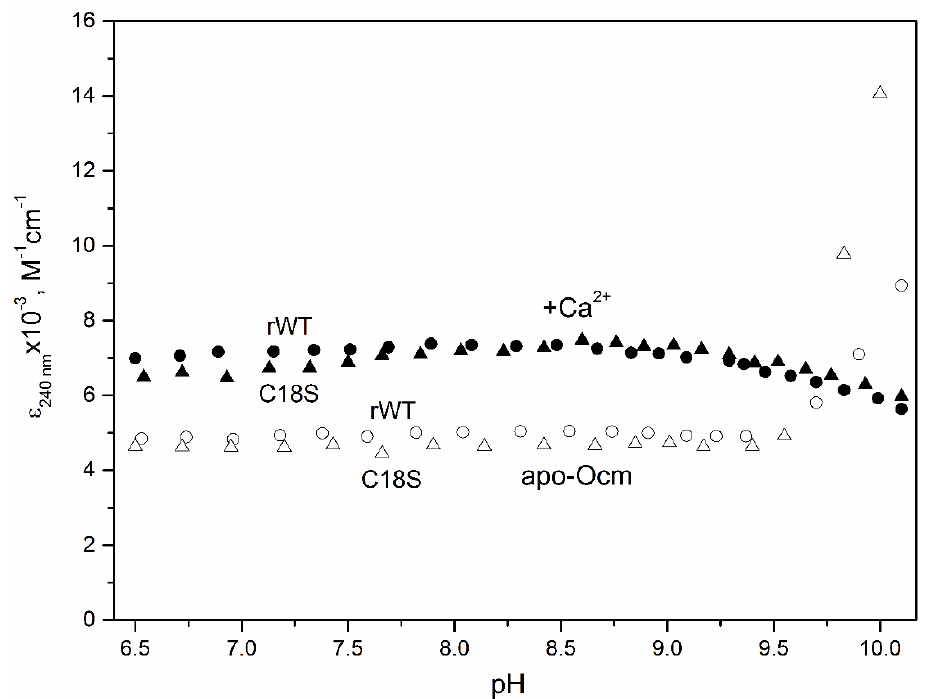
Figure 1. pH dependence of molar extinction coefficient at 240 nm at 20 °C, after subtraction of contribution of the deprotonated Tyr residues, for apo- (open symbols) and Ca 2+ -loaded (solid symbols) forms of reduced rWT Ocm (circles) and C18S Ocm (triangles). Protein concentration was 23 μM. Buffer conditions: 30 mM MES, 30 mM HEPES, 30 mM H 3 BO 3 , 30 mM glycine, 100 mM KCl, 1.5 mM EDTA (apo-Ocm), or 1 mM CaCl 2 (Ca 2+ -bound Ocm).